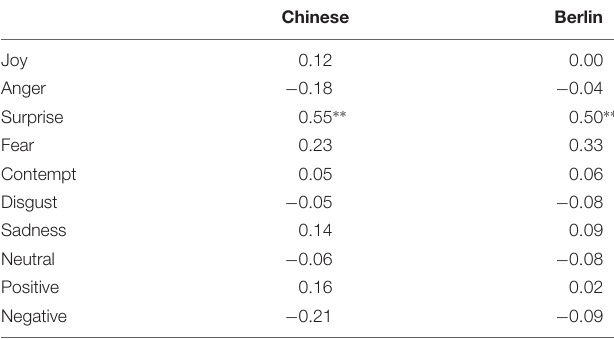
TABLE 4 | Spearman correlations of Chinese and Berlin wisdom ratings with different emotions during the scenario “A friend’s unrealizable